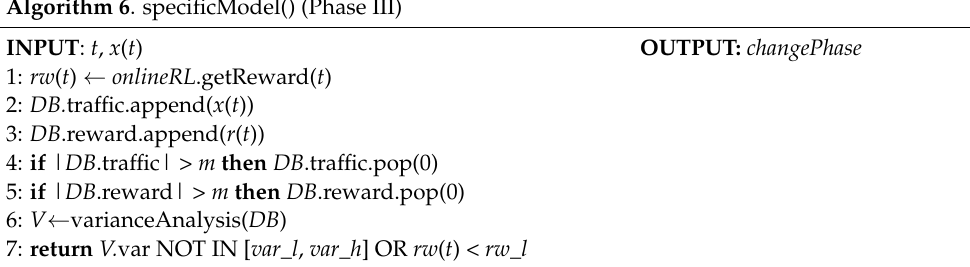
Algorithm 6 . specificModel() (Phase